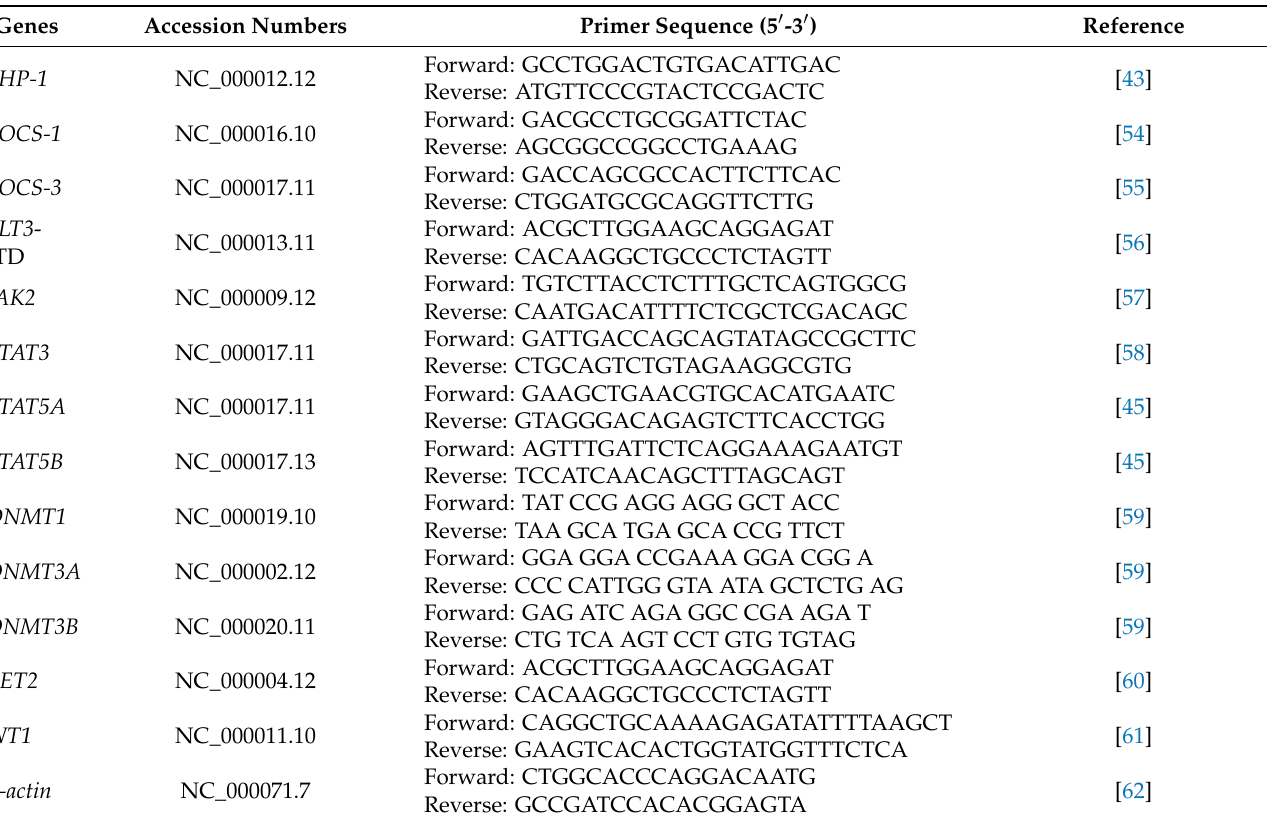
Table 5. Primer sequences for RT-qPCR